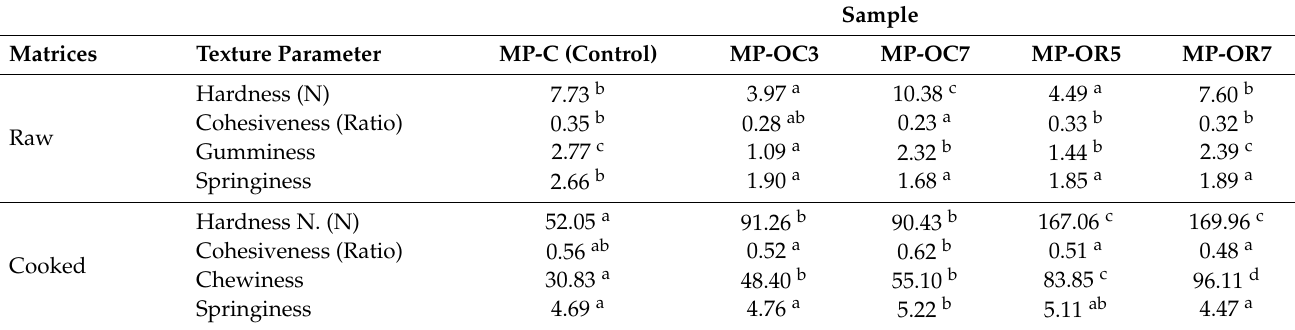
Table 5. Texture parameters of uncooked and cooked meat patties with different oleogels.